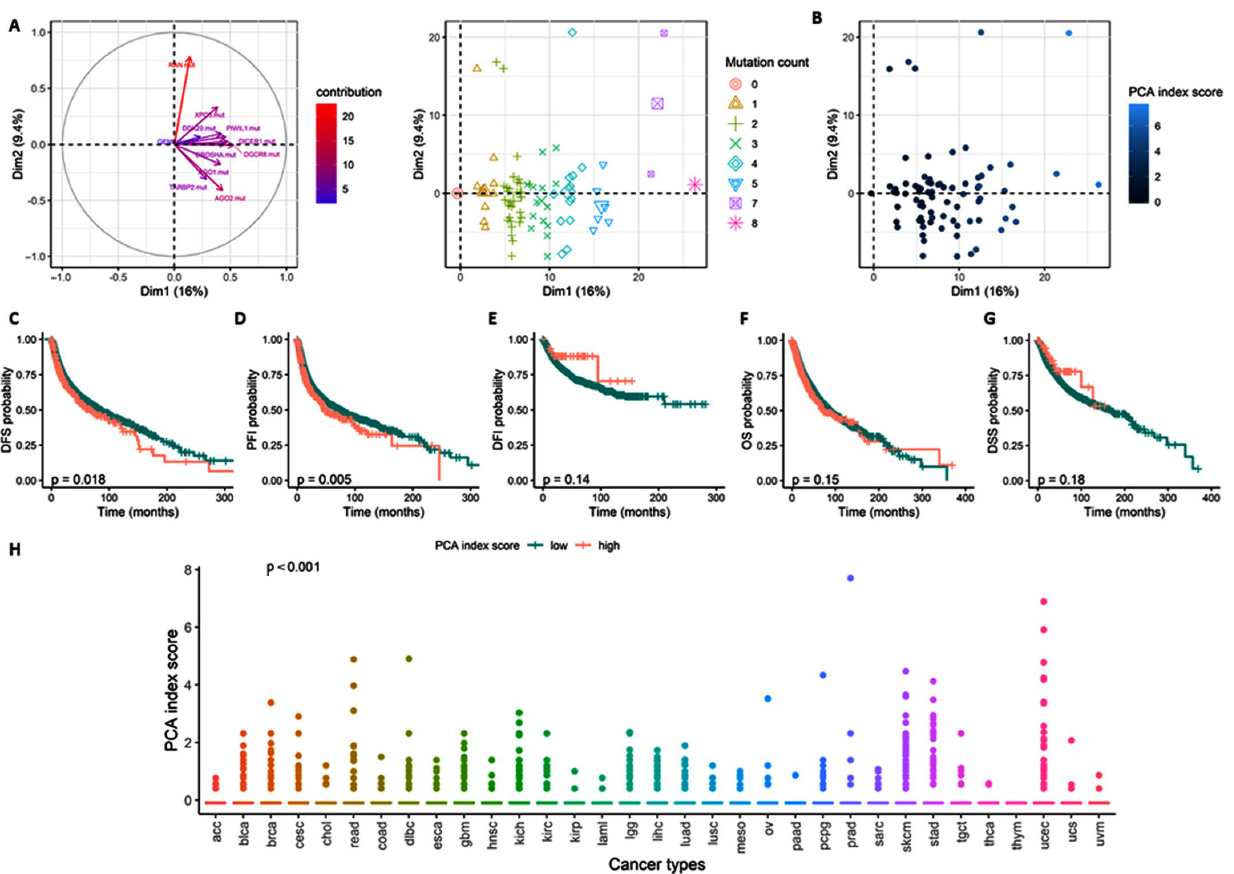
Figure 10. Principal Component Analysis using miRNA machinery gene mutations differentiated cancer samples. ( A ) Principal Component Analysis of the pan-cancer study according to the 11 gene mutants with the variable (left) and individual (right) plots, samples stratified according to the mutation count. ( B ) PCA individual plots are colored according to the PCA index score. ( C – G ) Kaplan–Meier curve estimated for the PCA index score according to DFS ( E ), PFI ( D ), DFI ( E ), OS ( F ), and DSS ( G ). Log test p-value. ( H ) PCA index score distribution across the cancer type. Kruskal test p-value. Significant p -value < 0.05. DFI, Disease-free interval; DFS, Disease-free survival; DSS, Disease-specific survival; OS, Overall survival; PFI, Progression-free interval.